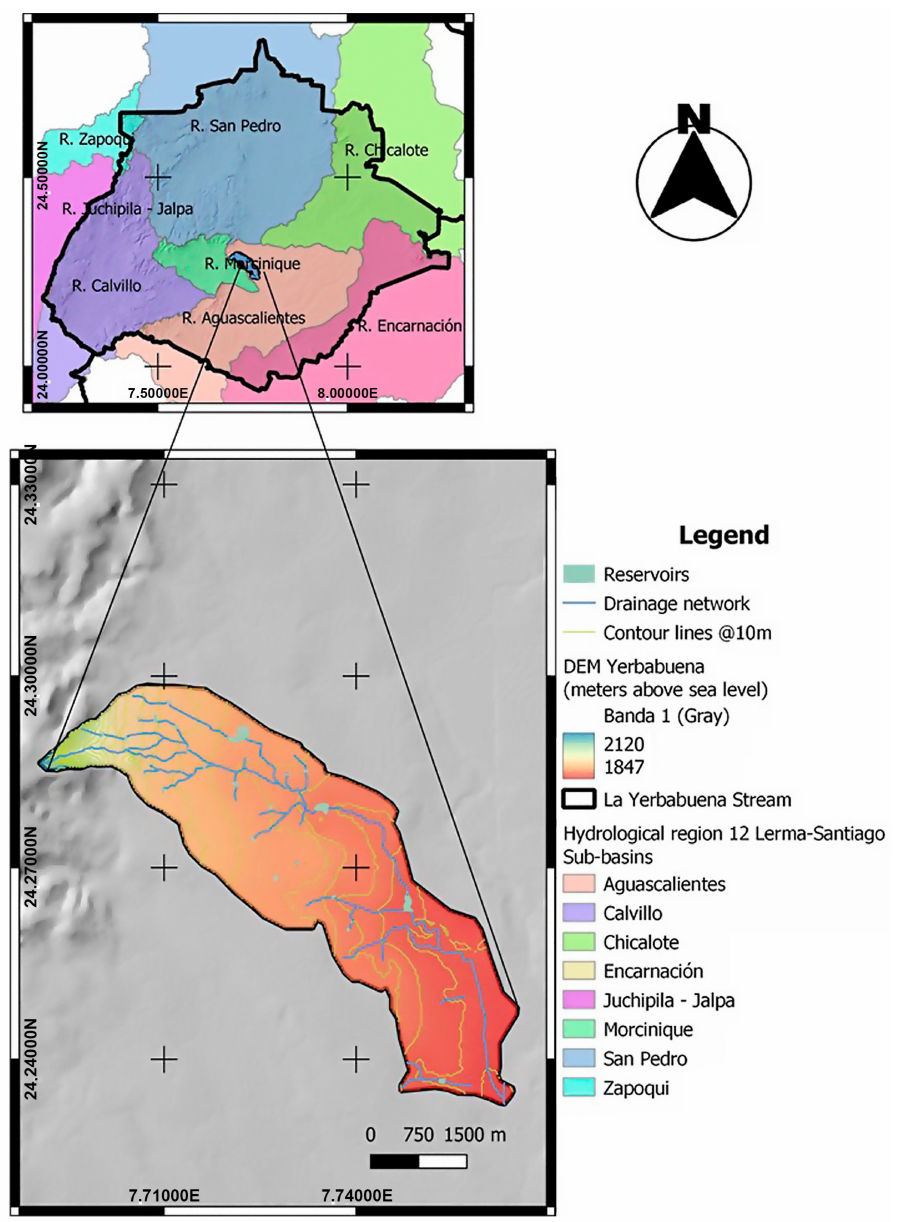
Figure 3. Description and main characteristics of the study area, that includes the reservoirs, drainage network, and contour lines from the sub-basin “La